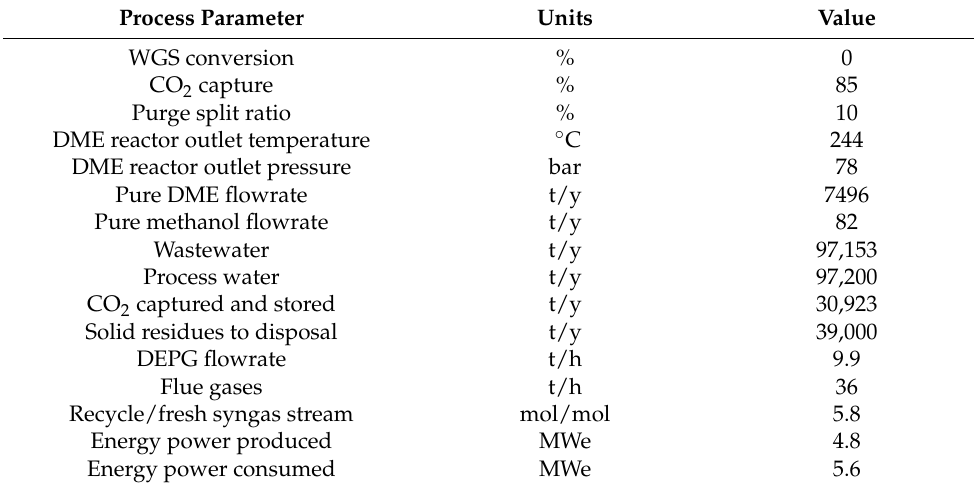
Table 3. Process